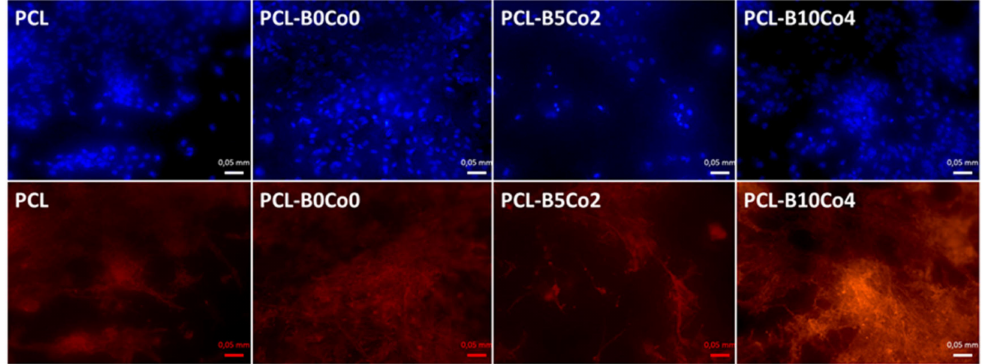
Figure 6. DAPI (blue) and rhodamine (red) fluorescent images of ST-2 cells directly cultured on PCL-BCo.BGNs mats for 7